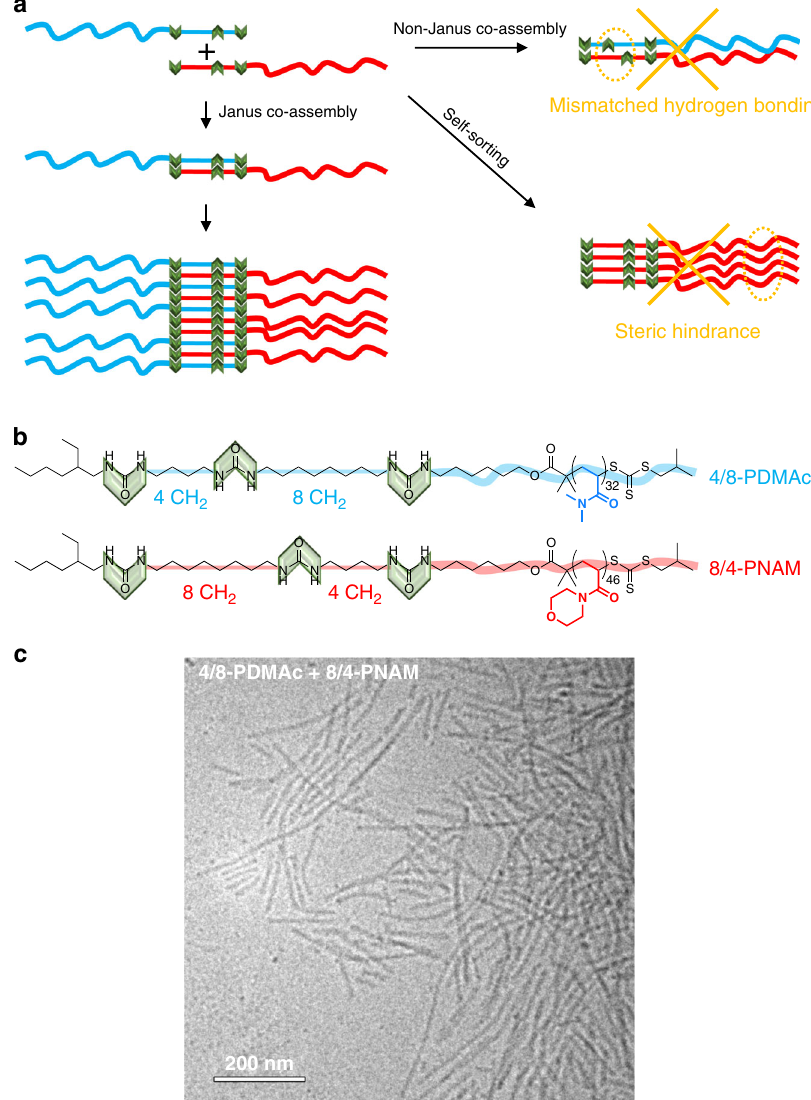
Fig. 1 Co-assembly. a Concept: the unsymmetrical stickers constrain the relative orientation of the polymer arms. Co-assembly is favored over self-sorting for entropic and steric reasons, while the Janus organization is favored because it allows optimal matching of the hydrogen bonding units. b Structure of 4/ 8-PDMAc and 8/4-PNAM. c Cryo-TEM image of (4/8-PDMAc + 8/4-PNAM) equimolar mixture (1 g L − 1 in water/DMSO (99/1